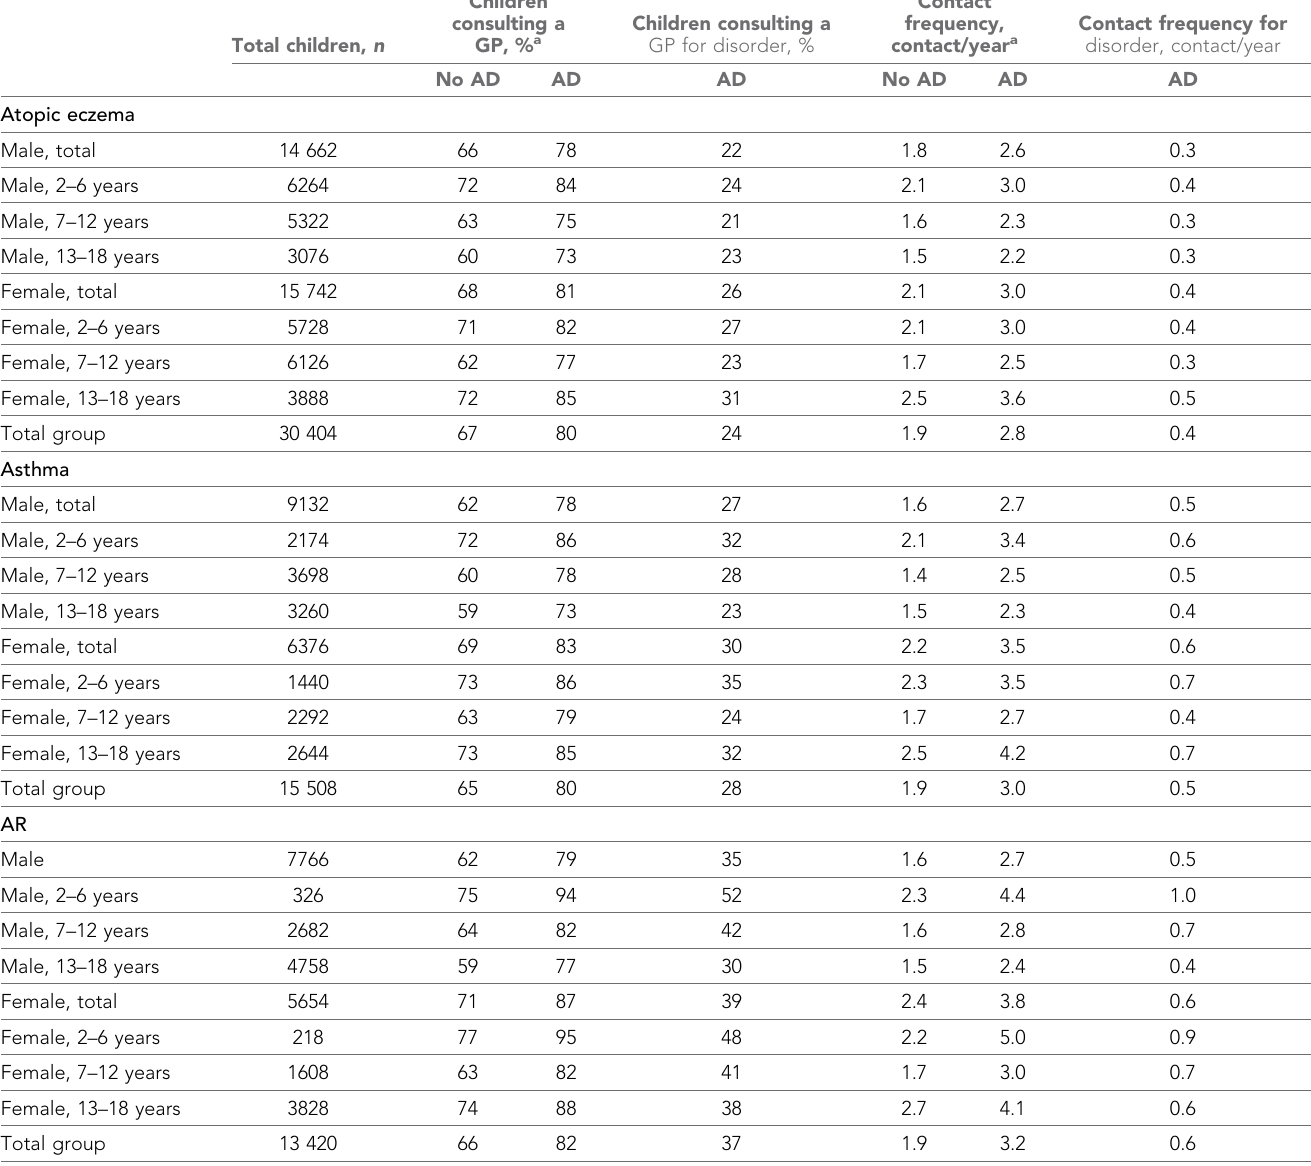
Table 1. Healthcare utilisation in 2014 for children with single AD (only atopic eczema, only asthma, or only AR) versus